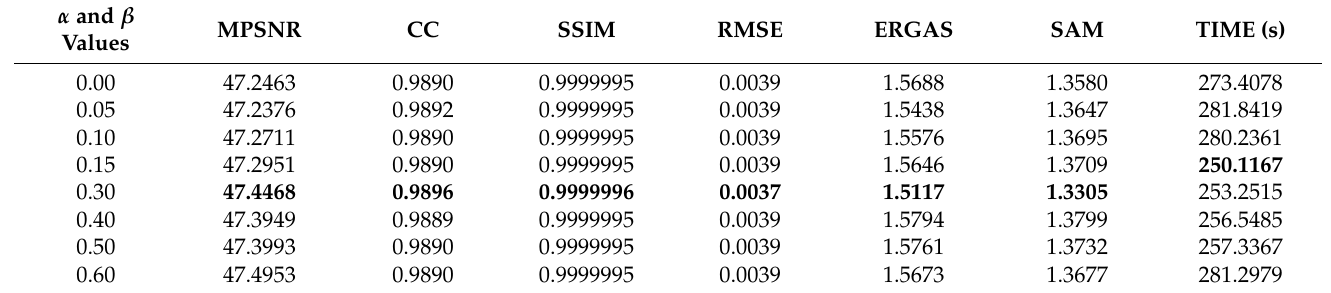
Table 2. Effect of the constraints on the proposed method in the Hyperspec Chikusei simulated data. α and β Values MPSNR